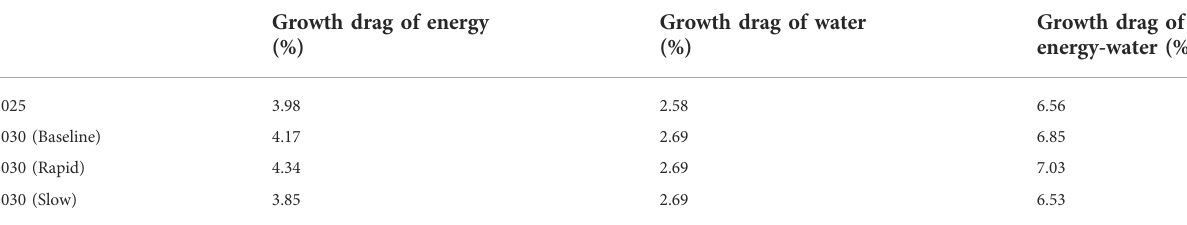
TABLE 4 Results of scenario